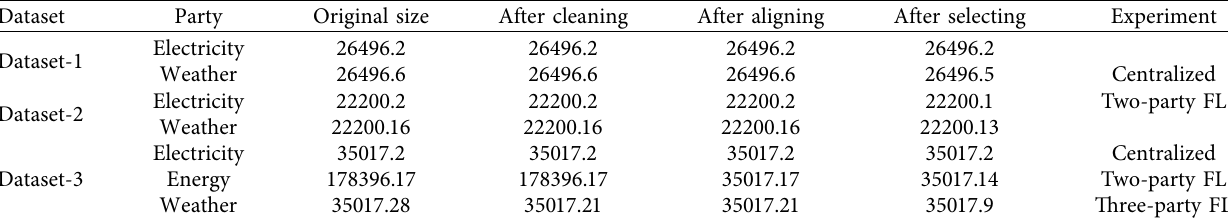
Figure 4: Demonstration of the splitting node in vertical Table 1: Descriptions of three used real-world datasets.